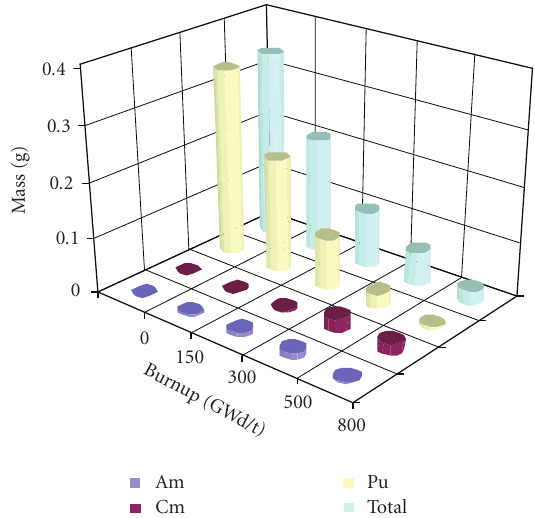
Figure 7: Masses of actinides versus fuel discharge burn-up (2/3 Th – 1/3 Pu)